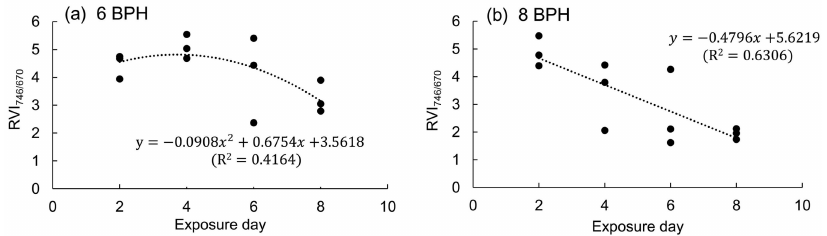
Figure 8. RVI 746/670 of a rice plant exposed to 6 ( a ) and 8 BPH nymphs ( b ) for 2–8 days.